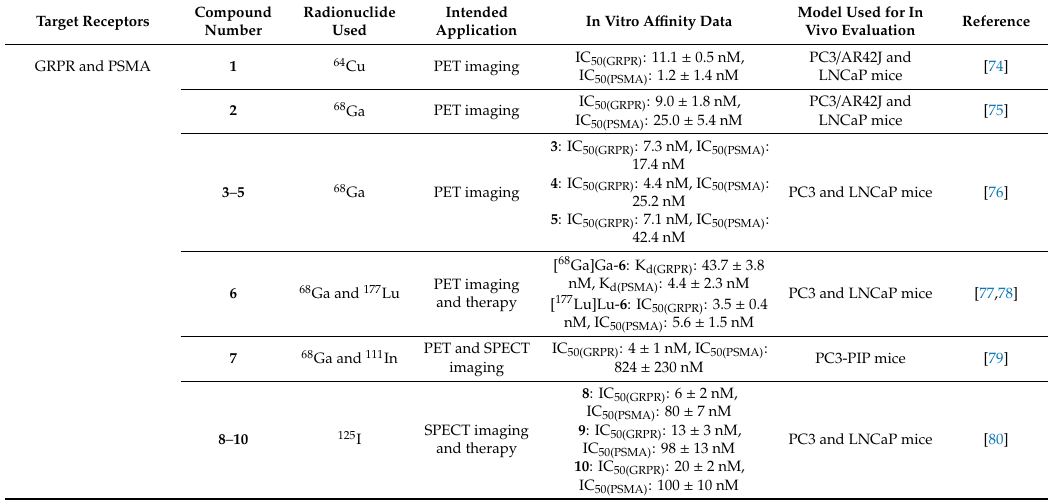
Table 1. Radiolabeled heterobivalent peptides developed for tumor imaging or therapy thus